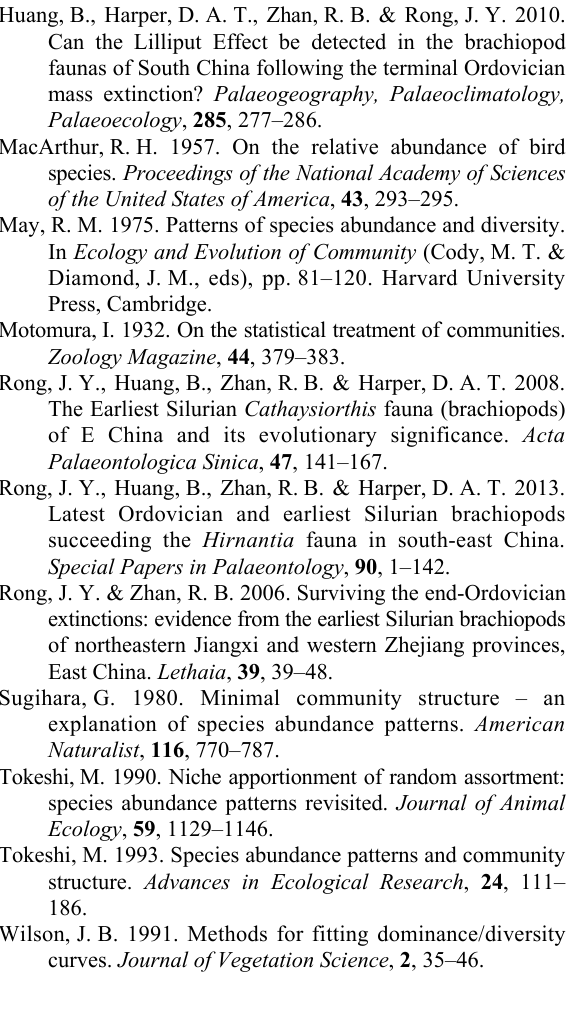
Fig. 2. Assignment of benthic assemblages (BA) of the four collections; the specimen number of the collections is